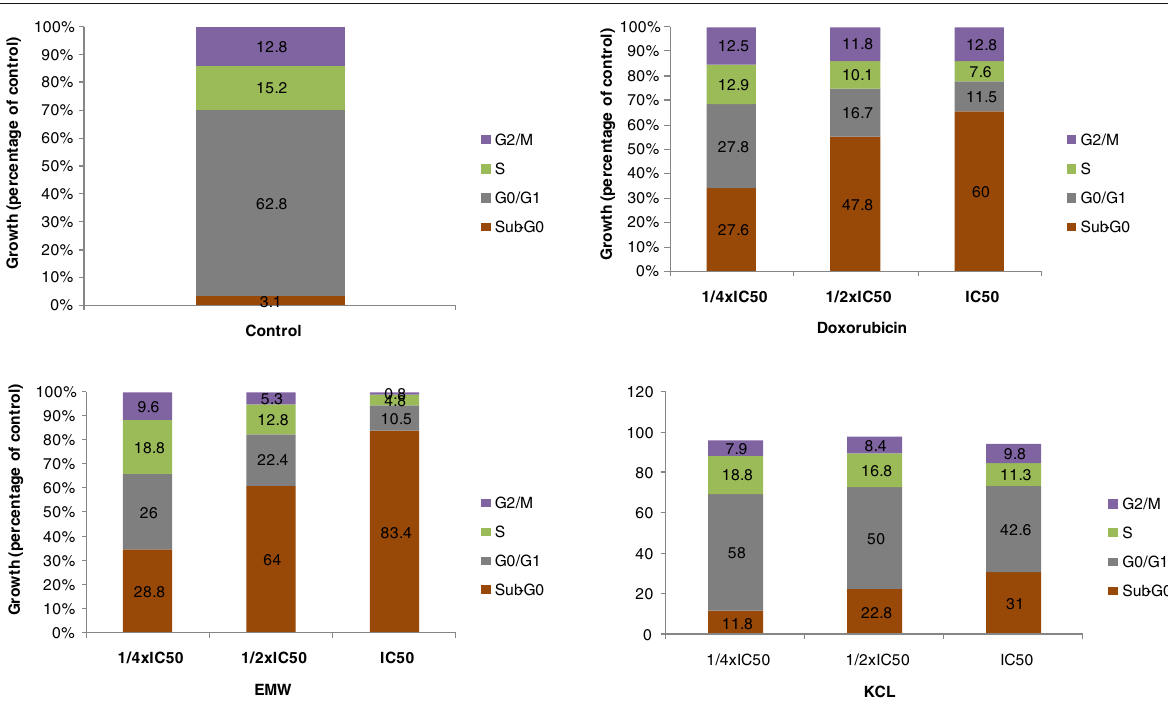
Fig. 1 Effects of the extracts from the whole plant of Elephantopus mollis (EMW), Kalanchoe crenata leaves (KCL) and doxorubicin on cell cycle distribution in MCF-7 cells. IC 50 values were 3.97 μ g/mL (EMW), 19.31 μ g/mL (KCL) and 0.32 μ g/mL (doxorubicin)